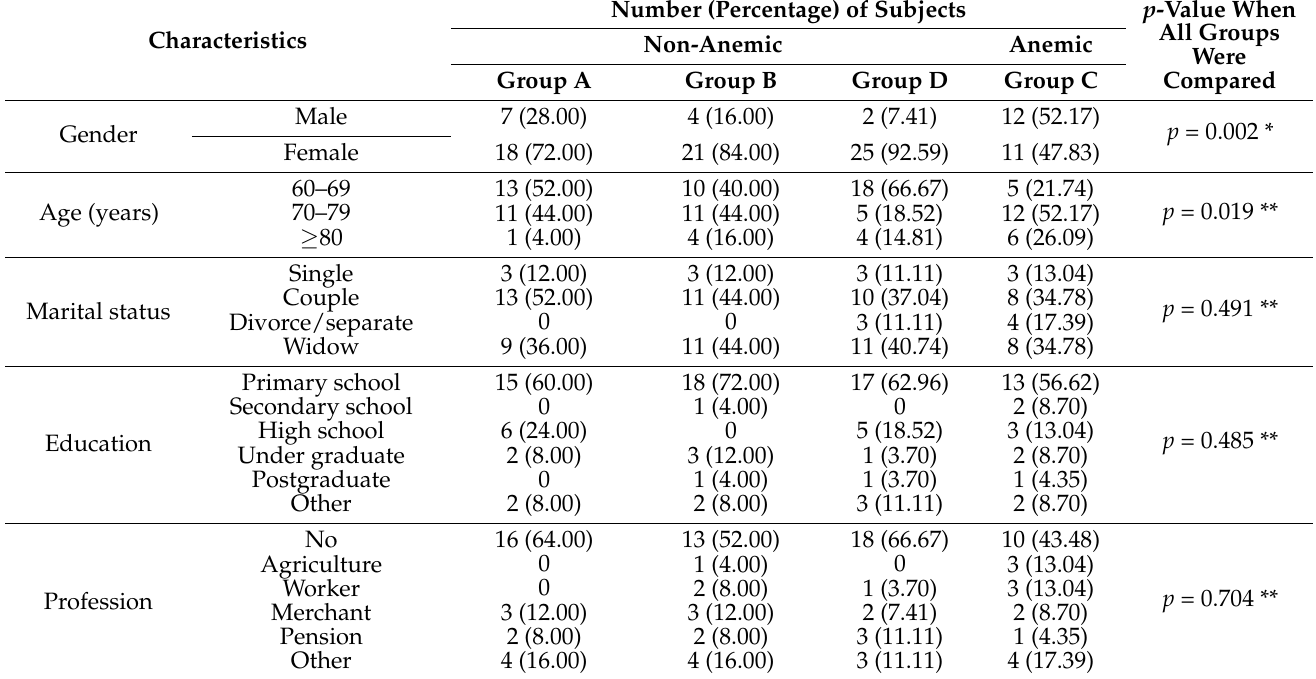
Table 1. General information of subjects in groups A, B, D and C before the study. Non-anemic elders consumed a WR drink (2 mg iron/100 mL serving) (group A), IR drink (15 mg iron/100 mL serving) (group B) and IR drink (27 mg iron/100 mL serving) (group D), while anemic elders consumed the IR drink (15 mg iron/100 mL serving) (Group C). Data are expressed in absolute numbers and percentages (blanket). * Pearson chi-square test, ** Fisher’s exact test ( p < 0.05) when members of the same group were compared.